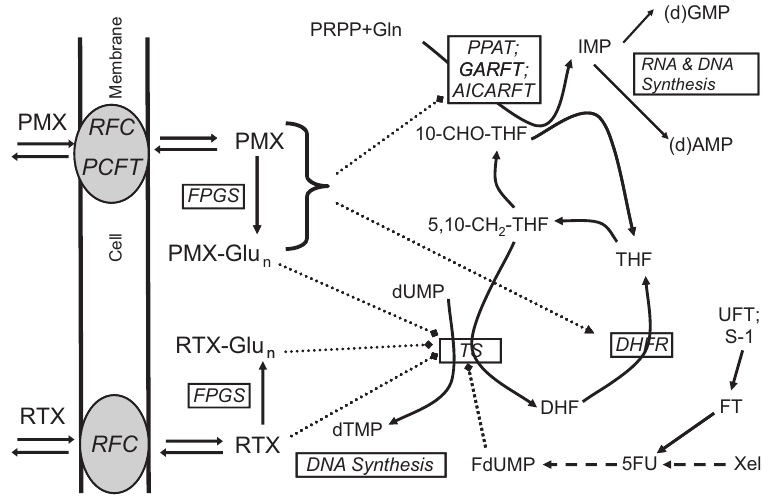
Figure 1 Uptake and metabolism of antifolates.